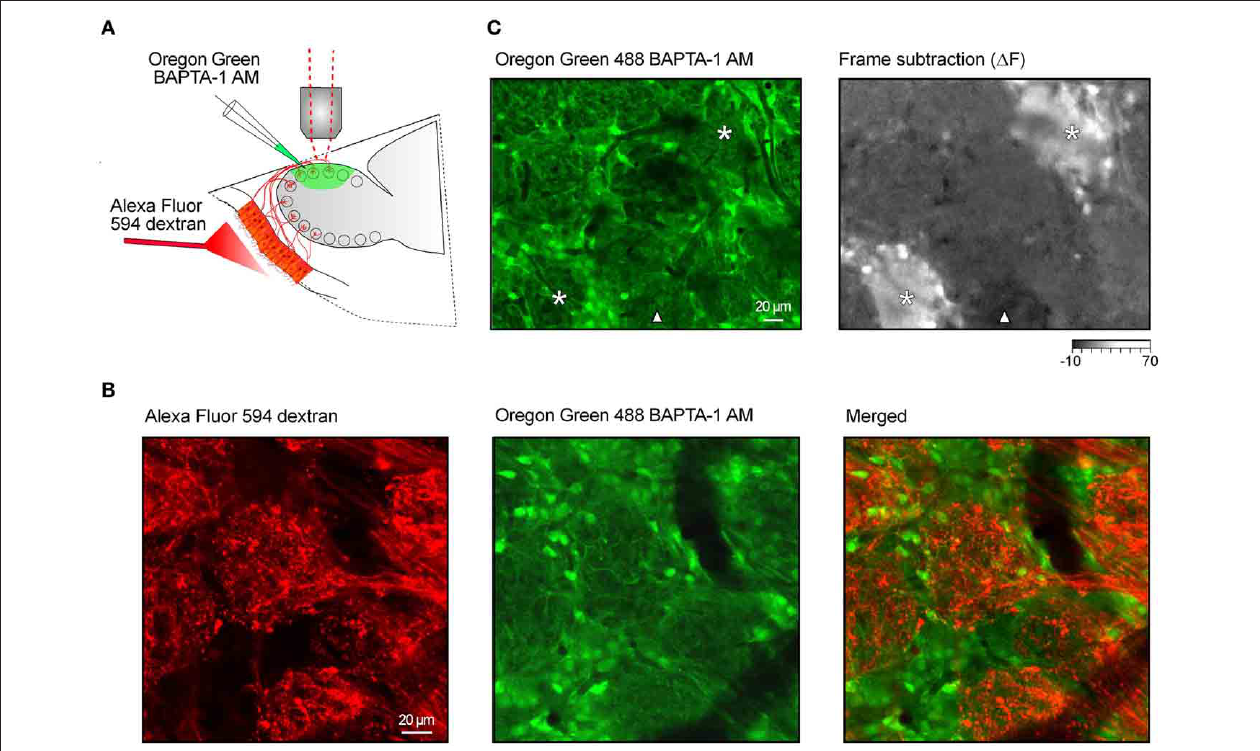
overlay of the two images. (C) Screening for locations with robust odorant responsesusingalowmagnification(20x)objectivelens.Leftpanel,animageof theglomerular layerlabeled withOGB-1.Rightpanel,aframesubtraction image obtained bysubtracting theaverage ofnineframesrecorded before theodorant presentation from a similar image recorded during the odorant presentation (2-hexanone, 1.5% of saturated vapor). Asterisks mark two odor-activated glomeruli; a triangle marks a glomerulus showing an odorant-induced decrease in OGB-1 fluorescence. The intensity scale is shown in arbitrary units